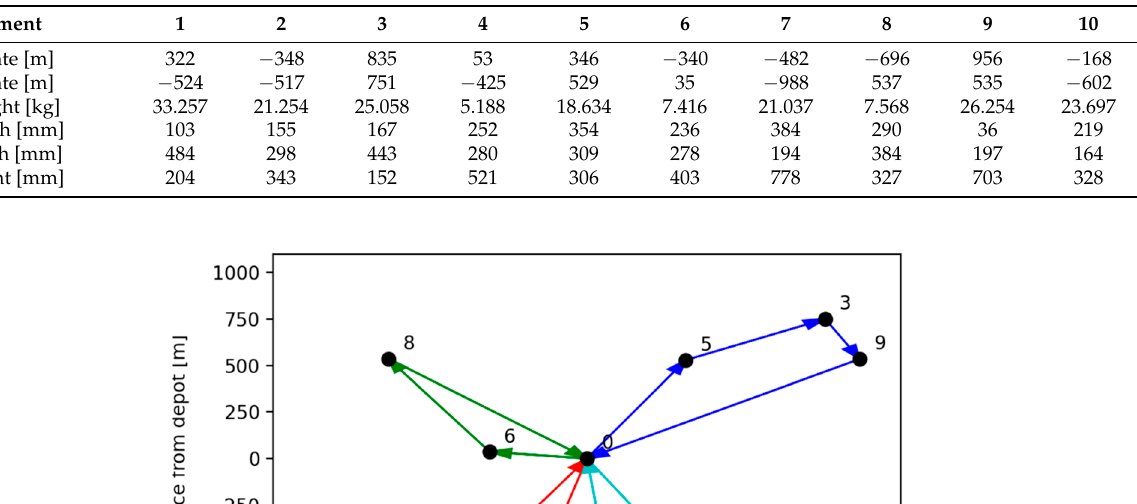
Table 2. Graphical representation of node locations and best route according to delivery time is shown on Figure 1. Table 2. Experiment data.